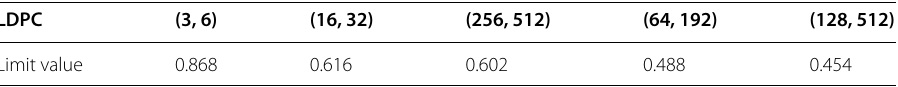
Table 1 LDPC convergence limits for different values d v , d c LDPC (3, 6) (16, 32) (256, 512) (64, 192) (128, 512) Limit value 0.868 0.616 0.602 0.488